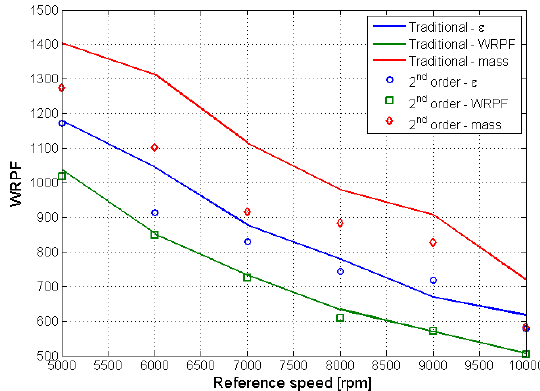
Figure 17. Second-order optimization: WRPF.